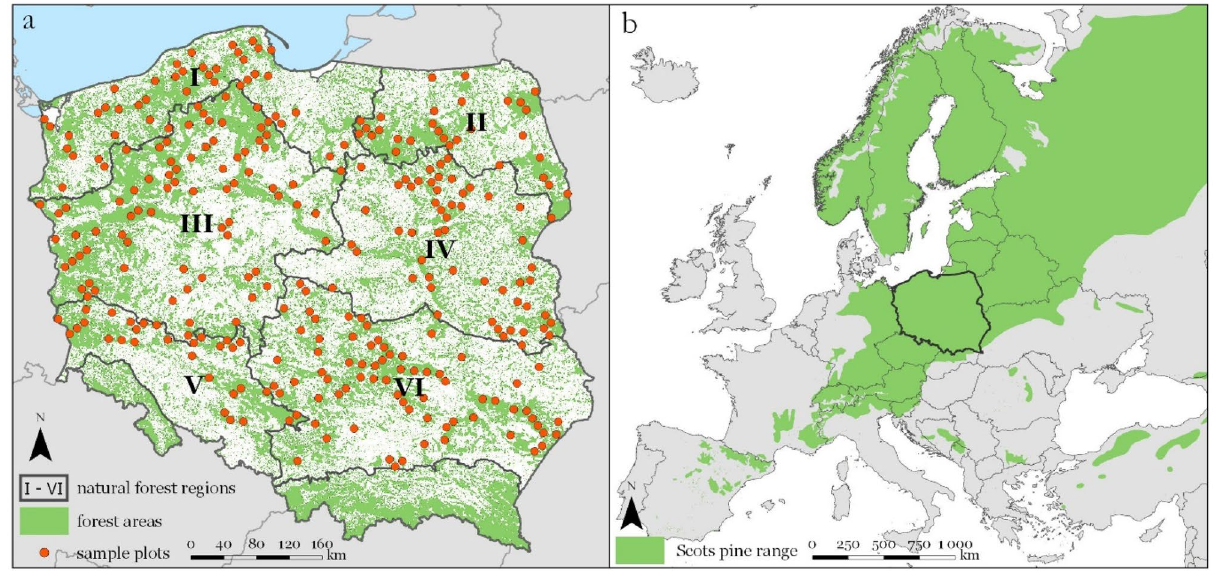
Figure 1. Natural forest regions in Poland with locations from which stem analysis data were collected ( a ); the range of Scots pine distribution in Europe ( b ). The map was generated using ArcGIS software 35 (ArcGIS Pro, Version 2.2.0, https:// www. esri. com/ en- us/ arcgis/ produ cts/ arcgis- pro/ overv iew). The Scots pine range shapefile published by Caudullo et al. 36 under the CC BY 4.0 open-access license was the basis for the